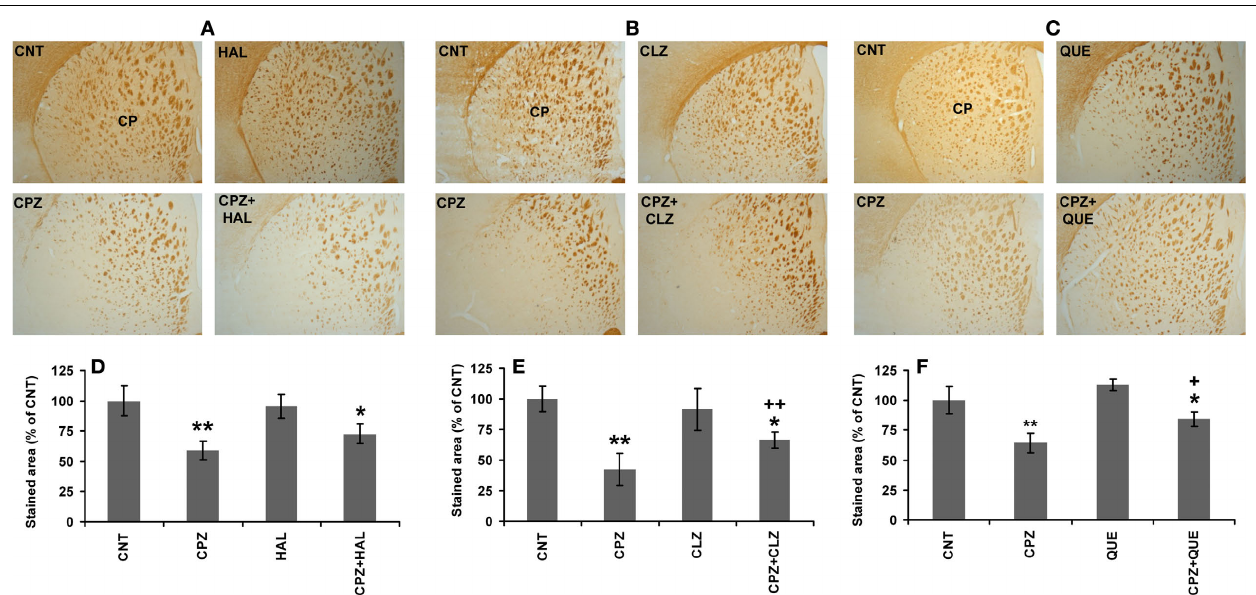
FIGURE 6 | CLZ and QUE, but not HAL, protect the CPZ-induced myelin sheath loss in CP. (A) Images showing MBP-like immunoreactivity (MBP-LI) in CP of mice in the HAL experiment. (B) Images showing MBP-LI in CP of mice in the CLZ experiment. (C) Images showing MBP-LI immunoreactivity in CP of mice in the QUE experiment. (D) The bar chart of MBP-LI area in tissue sections